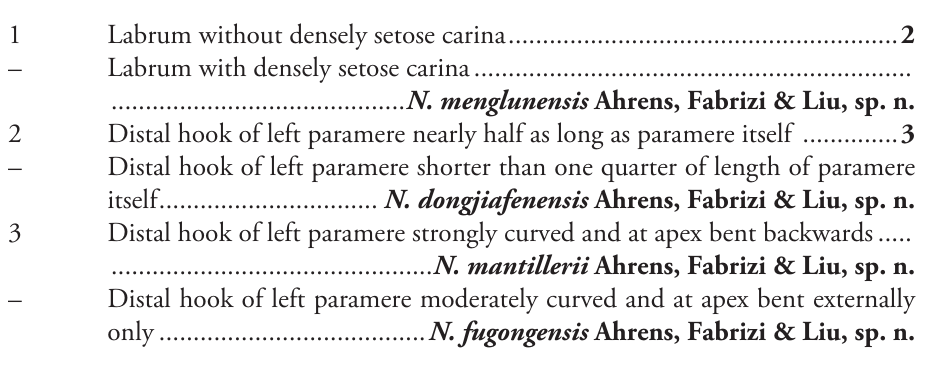
Type material examined. Holotype: ♂ “China (Yunnan) Nujiang Lisu Aut. Pref., Salween side valley, 5 km S Fugong, road SS228, km 223 (creek bank, litter sifted) 8.VI.2007 leg. D. Wrase/ X-DA1554” (ZFMK). Diagnosis. The new species has the genitalia similar in shape to N. incompta Ah- rens & Fabrizi, 2009, but N. fugongensis differs by the lens-shaped labrum and lacking the anterior fringe of dense setae on the